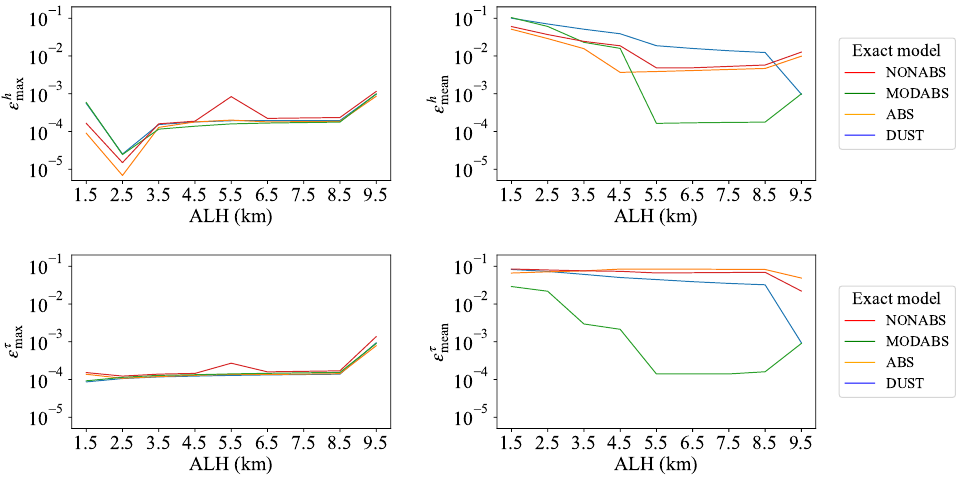
Figure 1. Relative errors ε τ , h mean,max ( τ e = 0.5, h e ) for the aerosol models from Set 1. ALH represents the aerosol layer height.